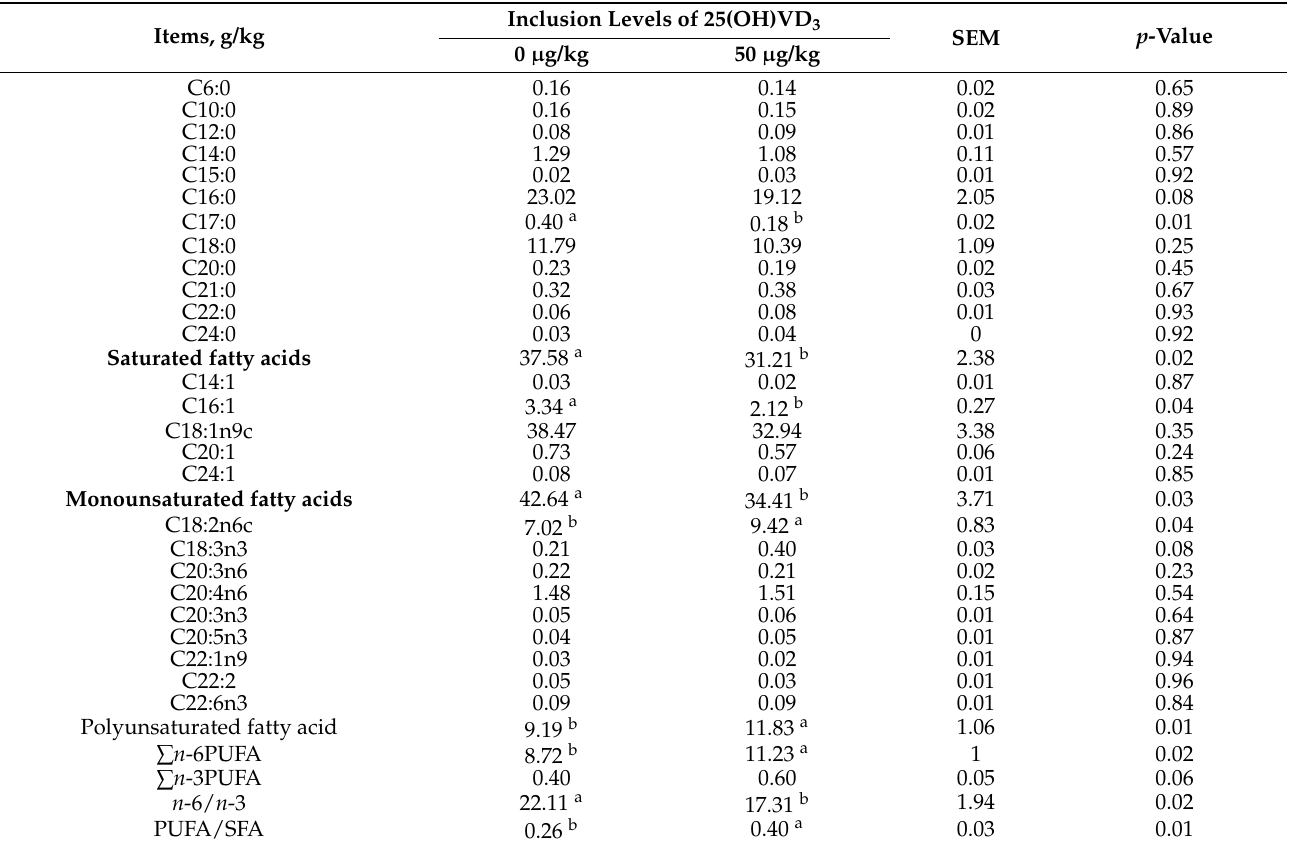
Table 6. Effects of the dietary addition of 0 and 50 µ g/kg 25(OH)VD 3 on fatty acid composition of pork longissimus dorsi in growing-finishing pigs.